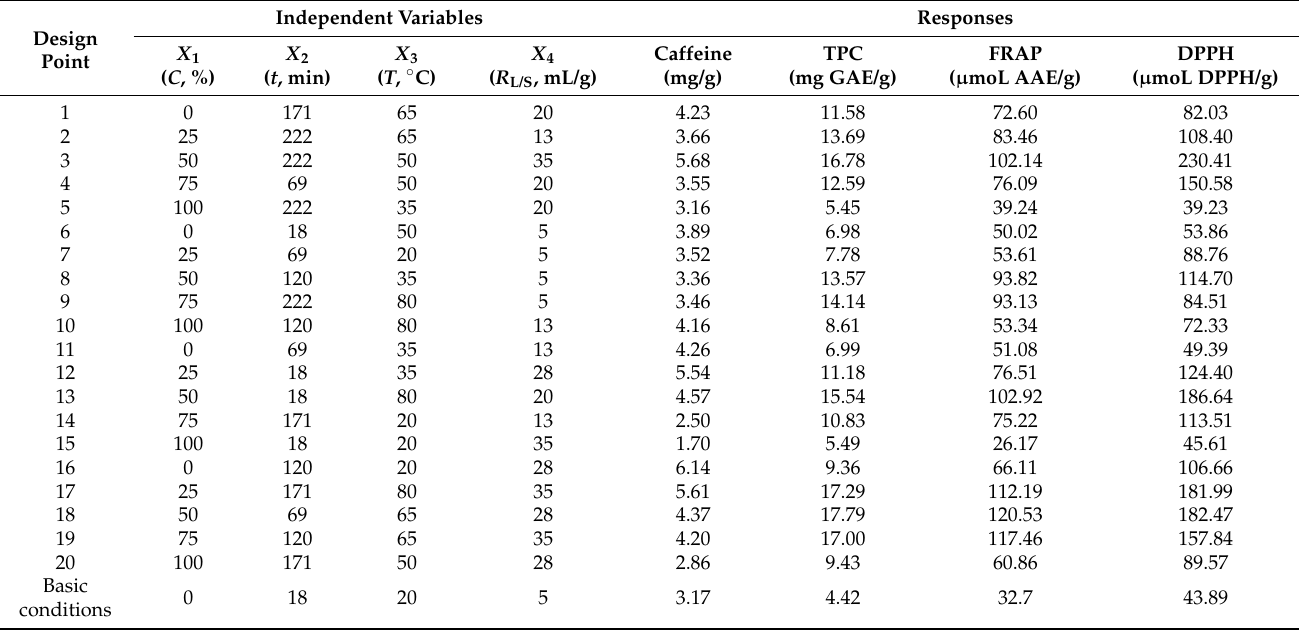
Table 2. Experimental values of the four independent variables investigated and responses of the dependent variable (Caffeine, TPC, FRAP, and DPPH).